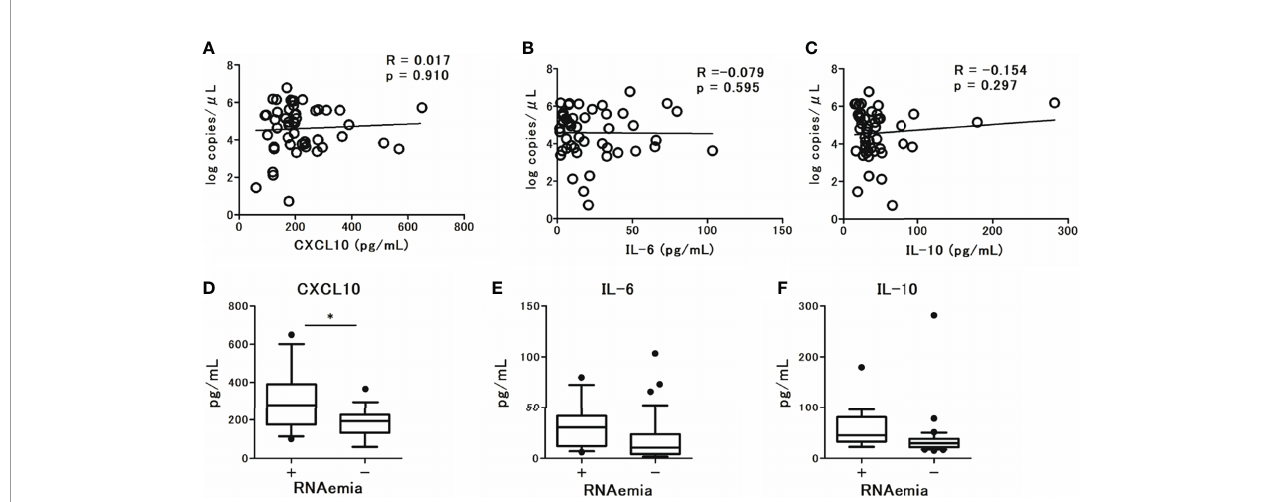
FIGURE 4 | The association observed between serum cytokine levels and SARS-CoV-2 viral load in nasal swab specimens from patients with COVID-19 at admission (within 5 days after the onset of symptoms): (A) CXCL10 levels, (B) IL-6 levels, and (C) IL-10 levels. Spearman correlation test was used, and Spearman correlation coef fi cient is shown. Corresponding logarithmic trendlines are shown. The association between serum cytokine levels in patients with COVID-19 and RNAemia: (D) CXCL10 levels, (E) IL-6 levels, and (F) IL-10 levels. One value was excluded from the analyses of IL-6 and IL-10 as an outlier (IL-6 with 476 pg/mL, and IL-10 with 1640 pg/mL). Data are presented as Tukey boxplots and individual values. Nonparametric Mann-Whitney test was used to compare values between groups: *p <